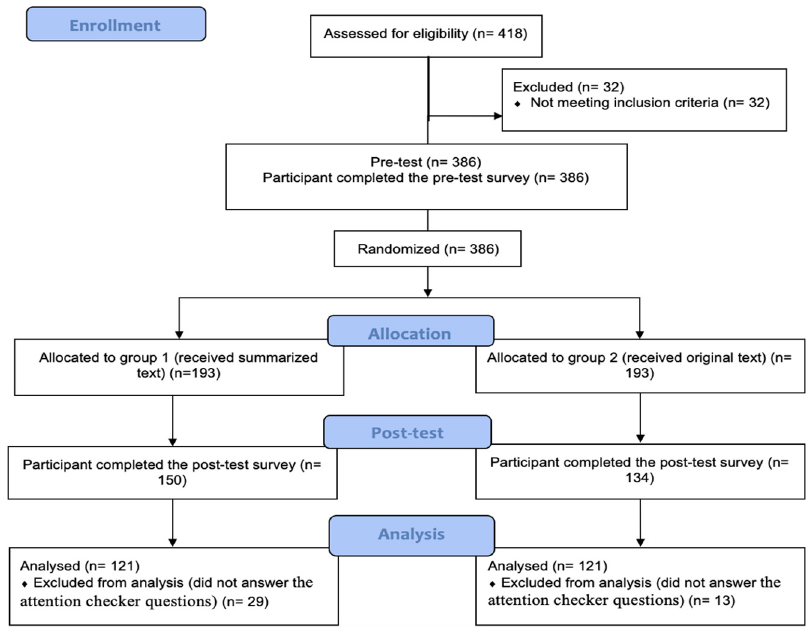
Figure 1. The flow diagram of the progress of the online randomized trial.